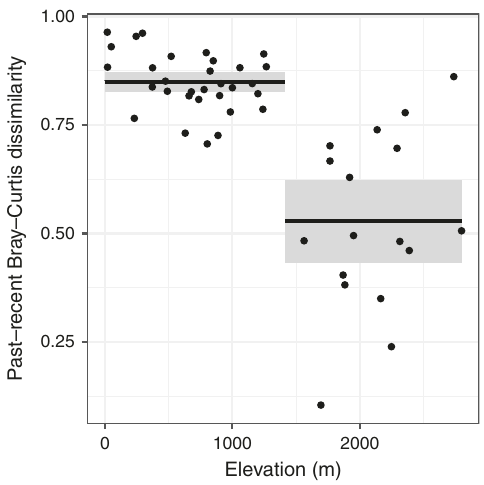
Fig. 3 Relationship between lake elevation and temporal turnover. Fitted regression tree model ( n = 48 lakes) is represented by black lines (mean values). Gray shading represents the 95% con fi dence intervals around means.